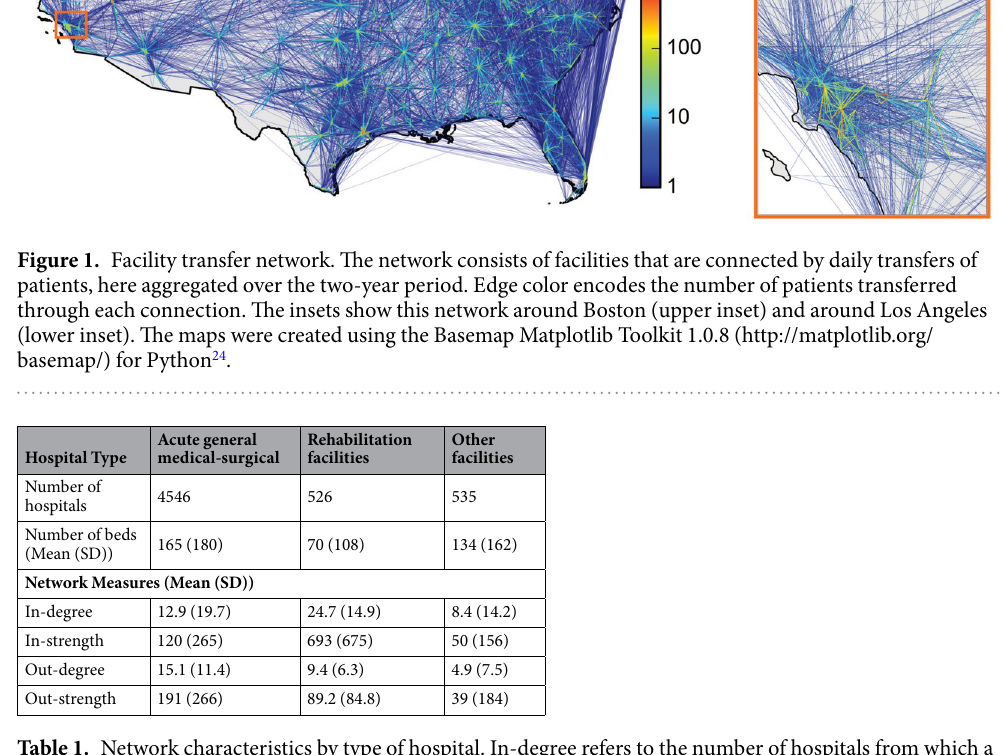
Table 1. Network characteristics by type of hospital. In-degree refers to the number of hospitals from which a hospital receives transferred patients. In-strength is the total number of transferred patients a hospital receives. Out-degree is the number of hospital to which a hospital transfers patients, while out-strength is how many patients a hospital transfers to other